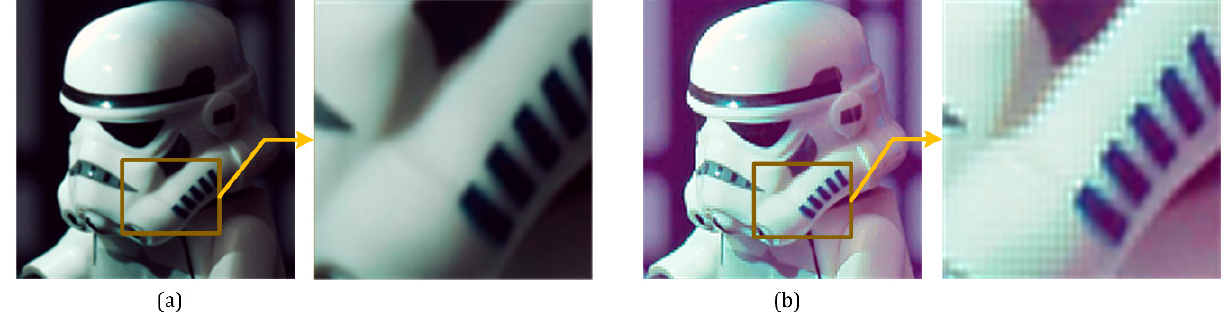
Figure 8. ( a ) Original image. ( b ) Reconstructed image by (29). According to discrete wavelet inverse transform, the image reconstructed by the scale